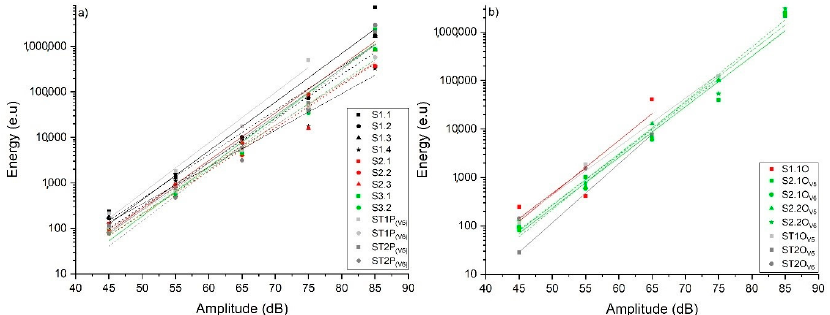
Figure A1. Average values of amplitude classes (<50 dB, 50 dB ≤ A < 60 dB, 60 dB ≤ A < 70 dB, 70 dB ≤ A < 80 dB, and ≥ 80 dB) vs. corresponding average energy of AE features. ( a ) Pine, brittle state; ( b ) oak, brittle state. Table A1. Equations of best fit curves shown in Figure A1 a,b, referring to the brittle state of tested specimens. Samples